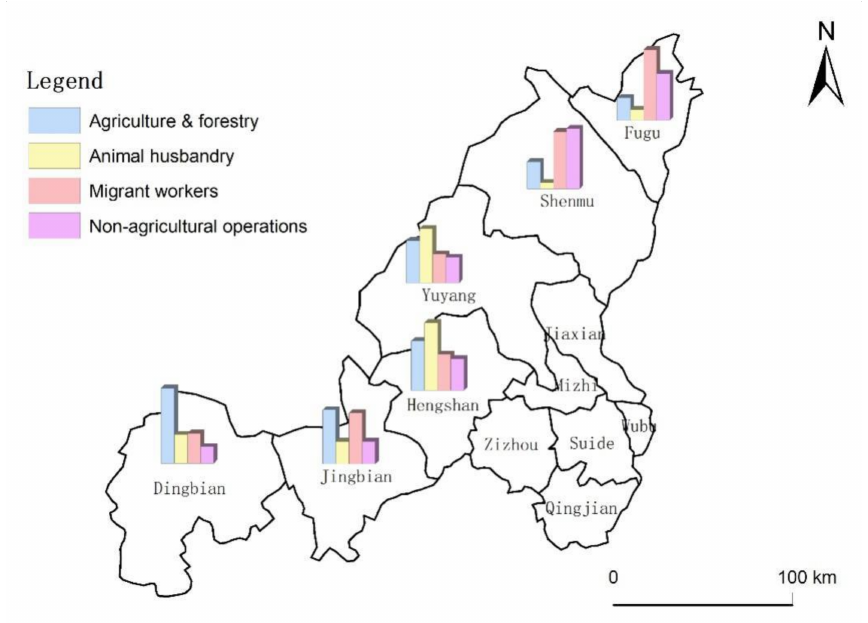
Figure 2. Livelihood activities of farmers in different